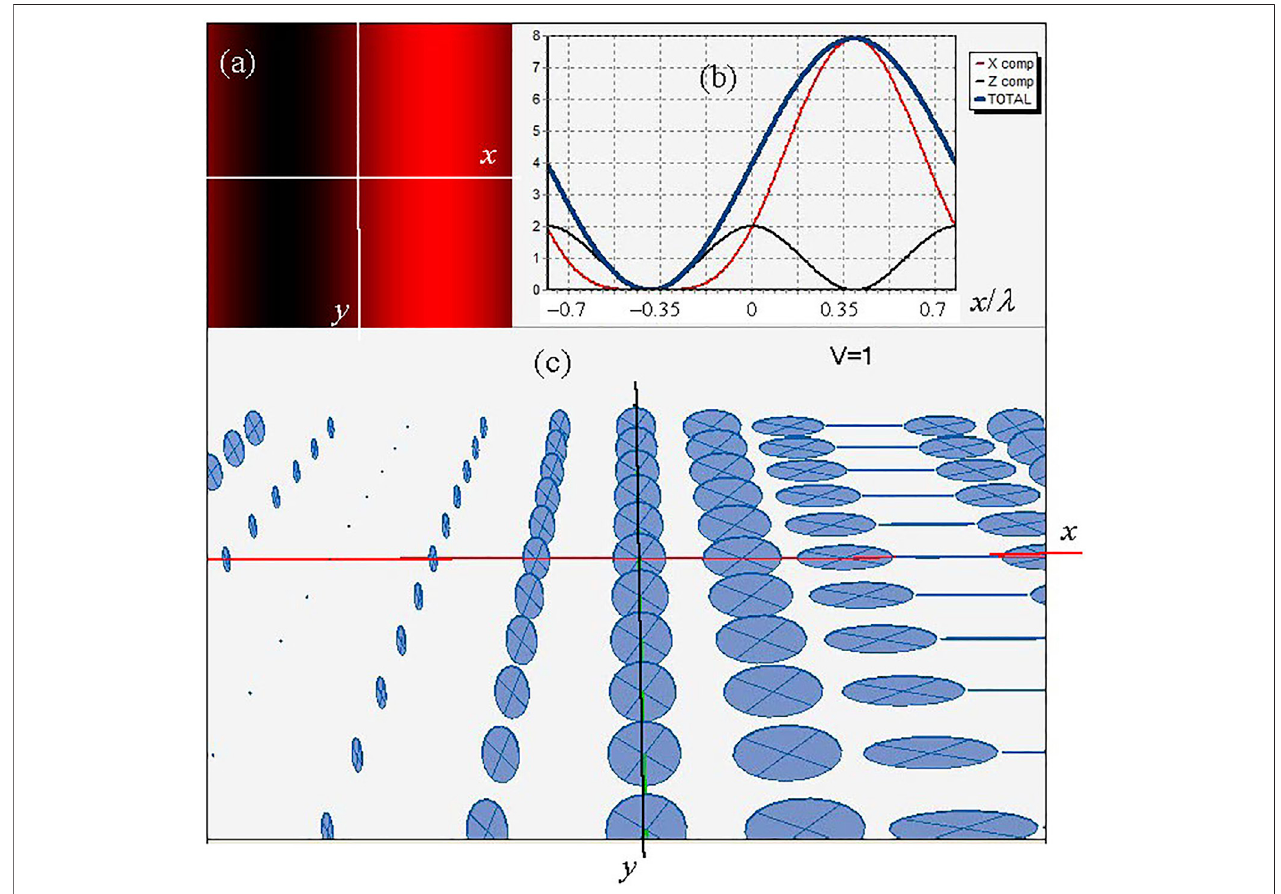
FIGURE4| Changeinthemodulationdepthoftheresultinginterference fi eldwiththeRWphasevariation. (A) 2Dintensitydistribution(cf. Figure3B ); (B) Intensities of the partial polarization components and the resulting fi eld; (C) schematic view of the polarization ellipses in different points of the ( x , y )-plane.